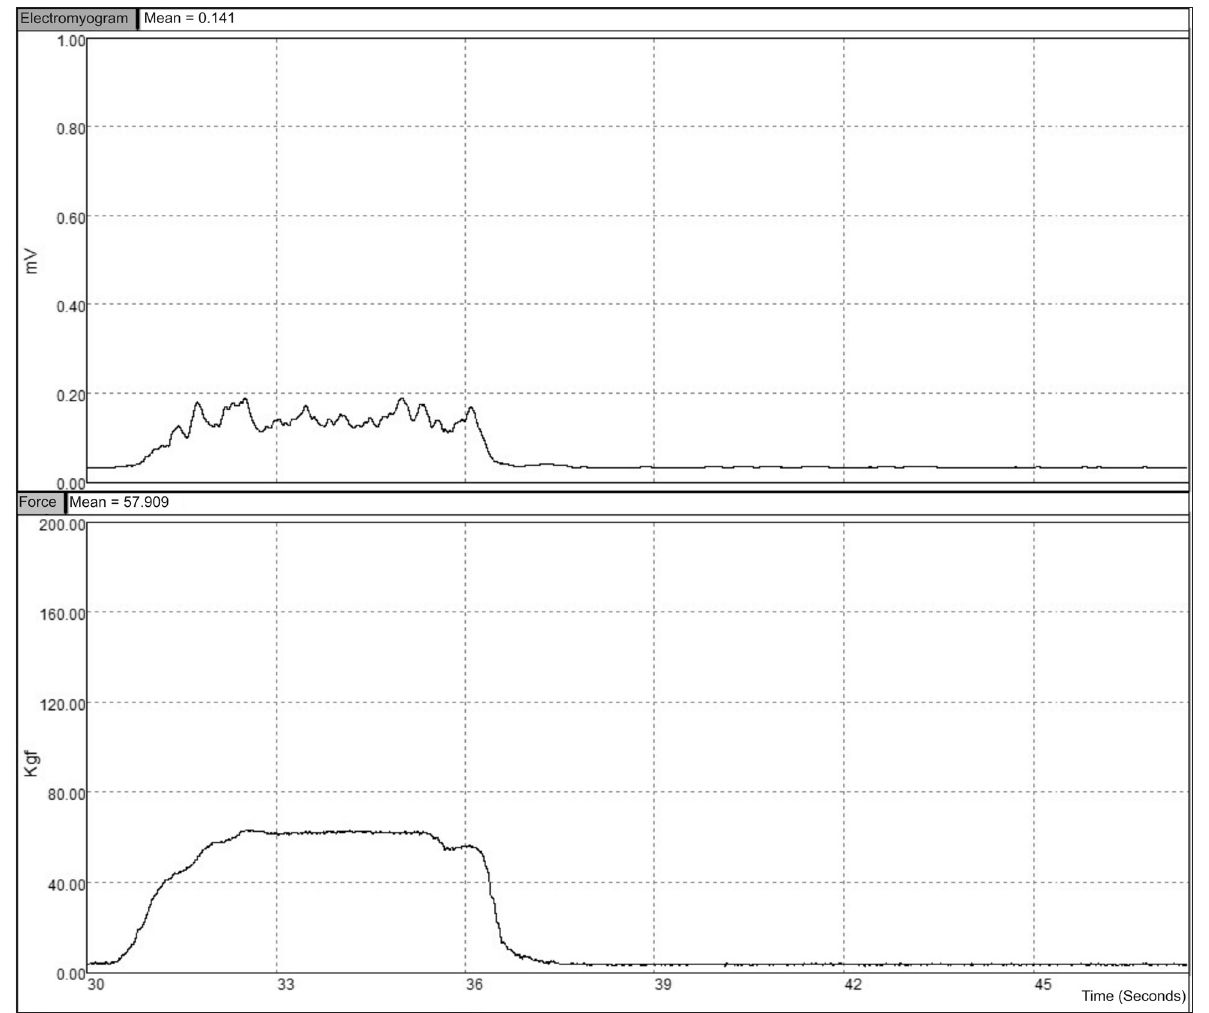
Figure 1. Visual presentation of the EMG low-pass envelope (upper panel) and force (lower panel) used as visual biofeedback in the Biomed